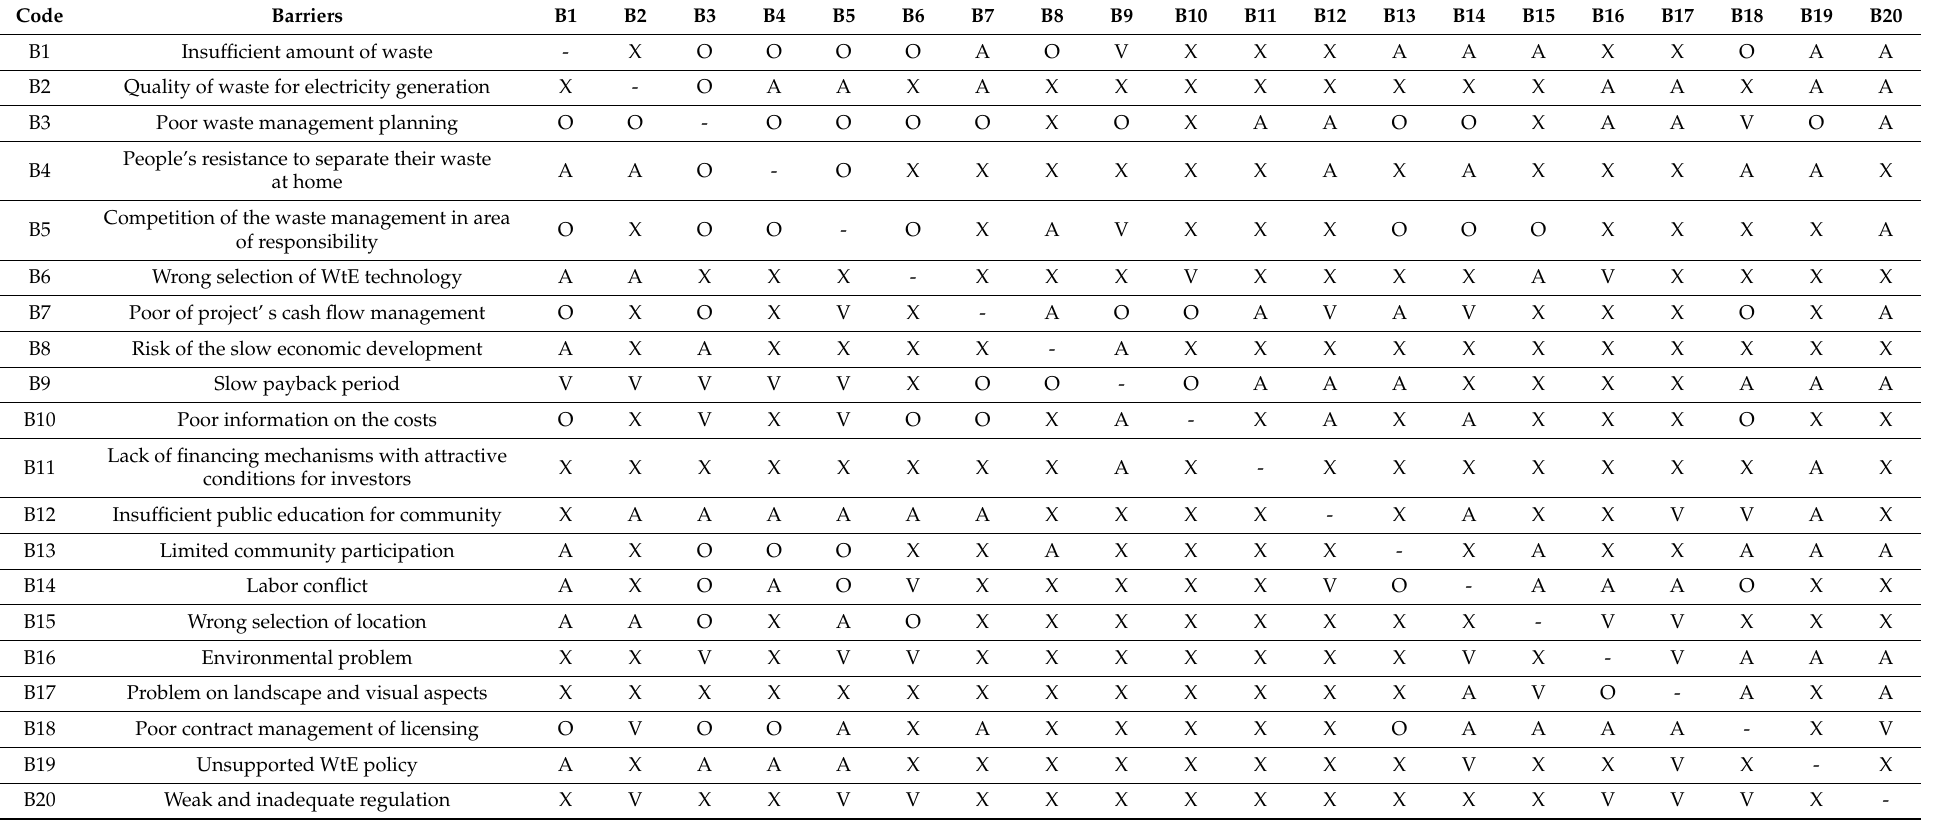
Table 3. Structural self-interaction matrix (SSIM-V, A, X, O) of this